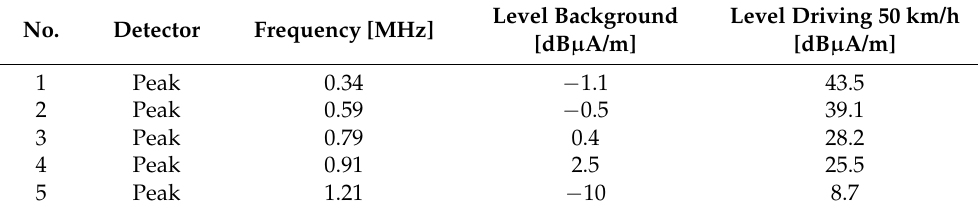
Table 2. Measurement method and the results obtained for individual frequency ranges for a rail vehicle travelling at a speed of 50 km/h and the OETD electromagnetic background level. No.